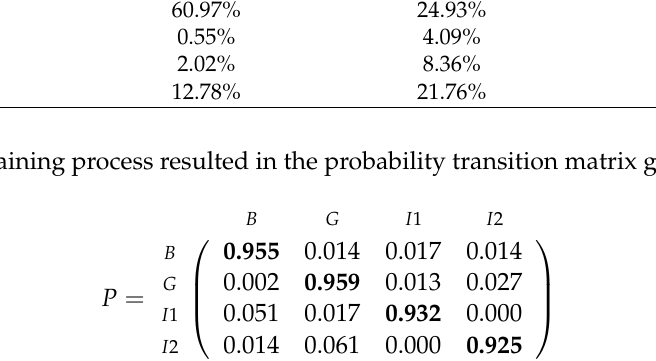
Table 3. Packet loss rate in each state. State PLR Standard Deviation